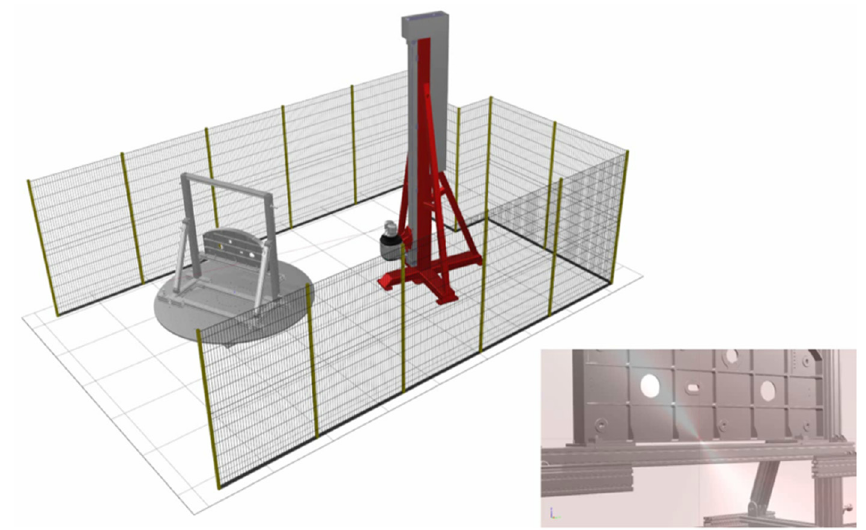
Figure 30. Illustration of the new and updated 3D scene in IPS LR software application.